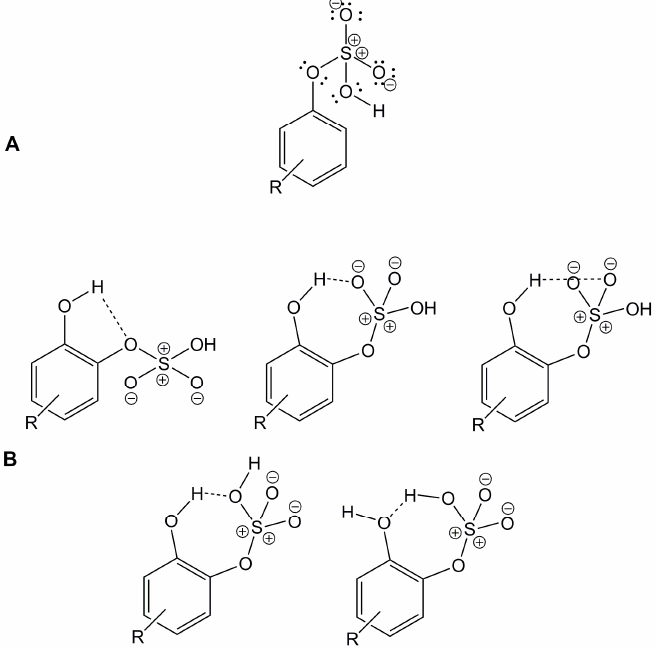
Figure 6. Model of structure of the aromatic sulfates ( A ) and possible intramolecular H bonds in phenols with sulfate group in ortho-position ( B ).